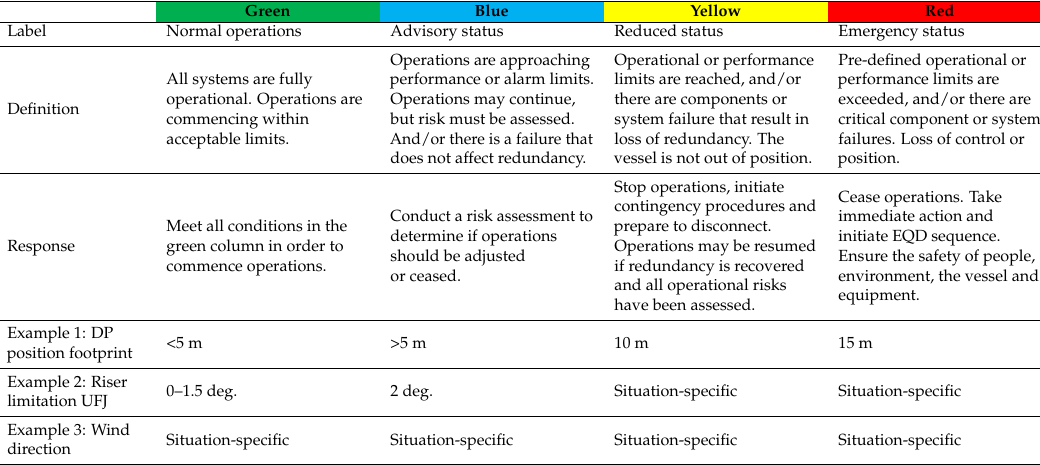
Table 1. Well specific operating guidelines, with examples of parameters containing precise and imprecise (“situation-specific”)